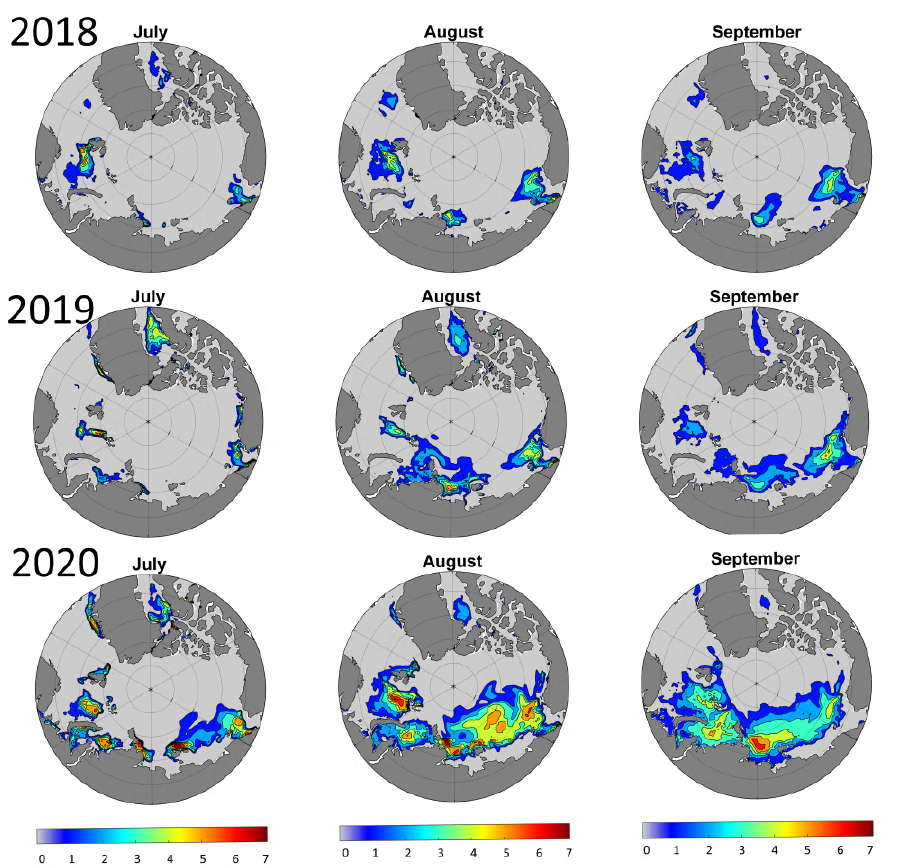
Figure 10. MHWs presented in terms of mean monthly temperature excess above the 90% threshold (in ◦ C) in summer 2018–2020 obtained from the results of a numerical experiment. Contour lines are from 1 to 6 ◦ C with 1 ◦ C